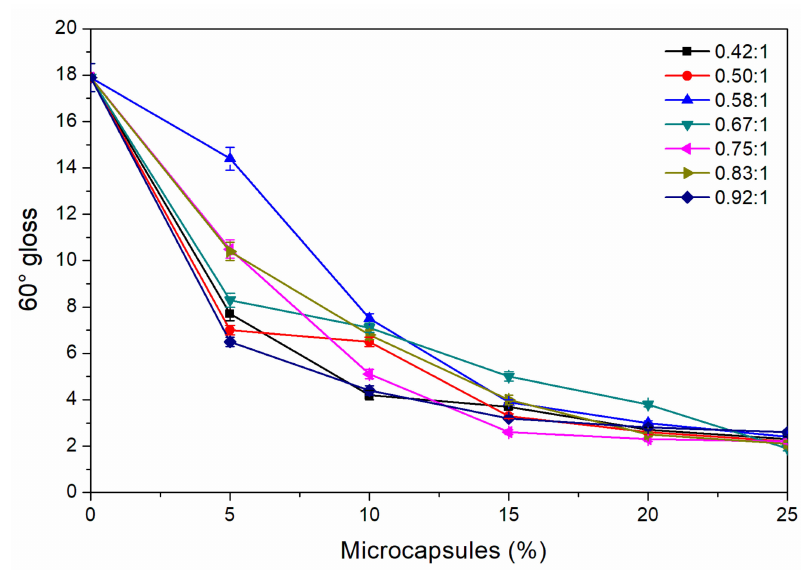
Figure 8. E ff ect of the concentration of microcapsules with the di ff erent core–wall ratios on the 60 ◦